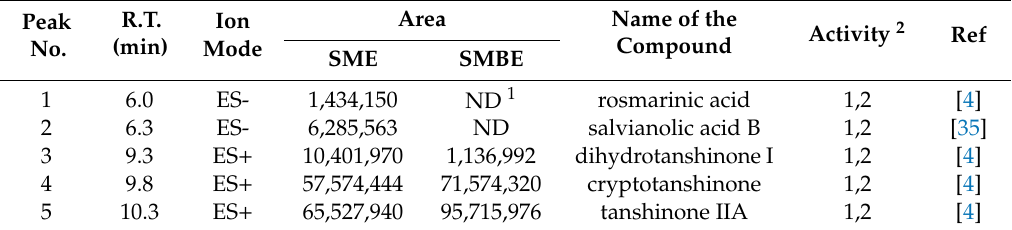
Table 6. Compounds detected by LC-MS analysis of S. miltiorrhiza ethanol extracts.